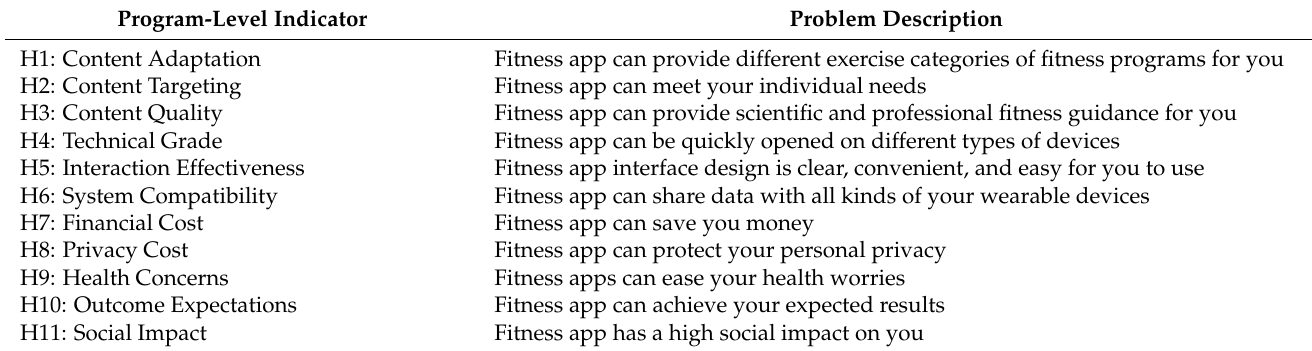
Table 2. Description of index conversion questionnaire.